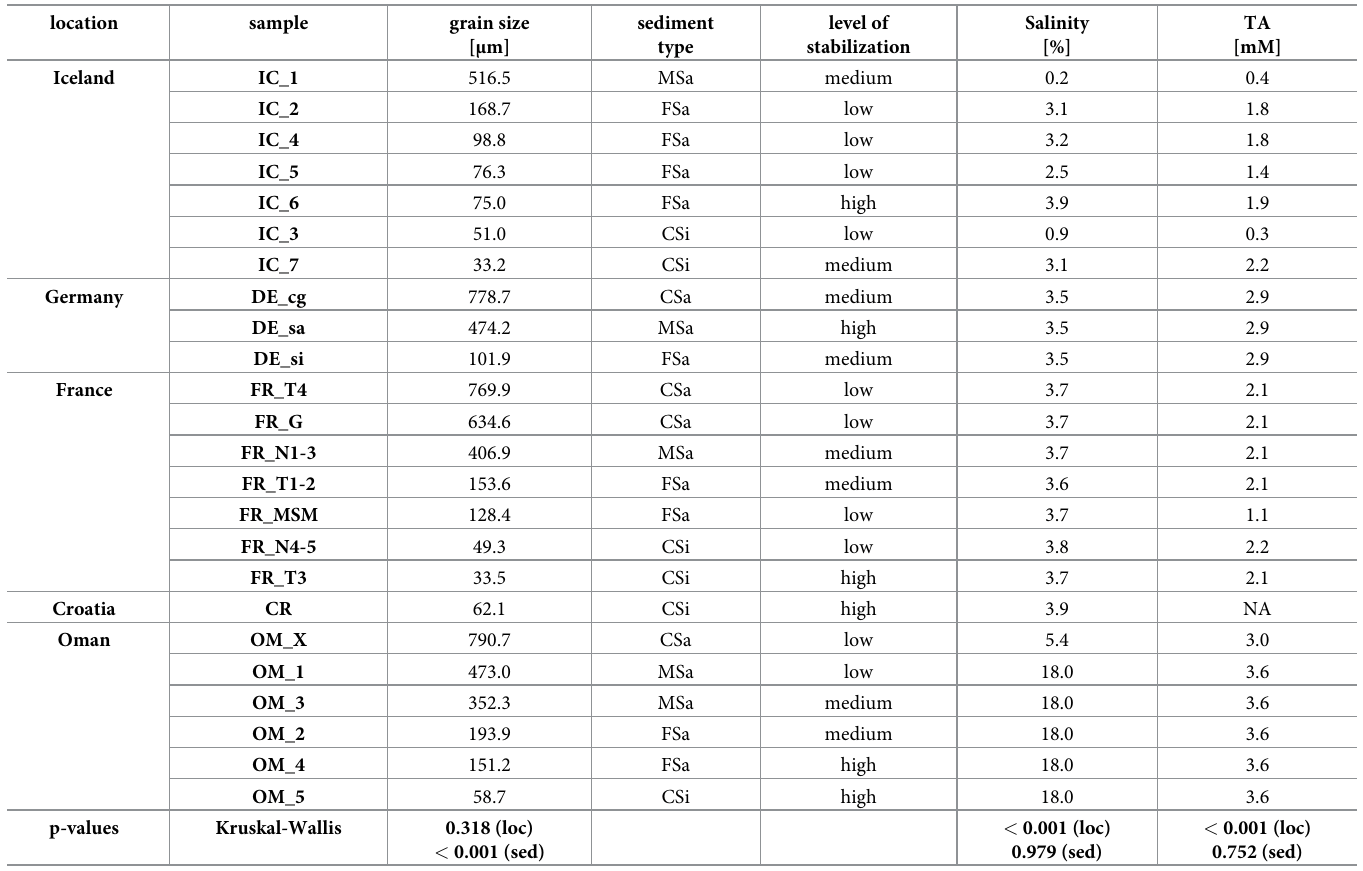
Table 3. Sediment and water characteristics of the sampling sites.